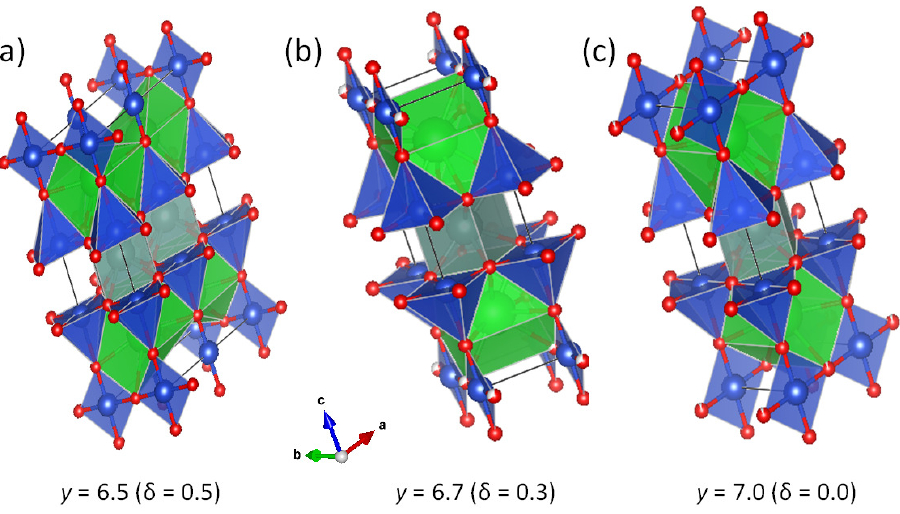
Figure 1. The crystal structures of ( RE )BCO as a function of the oxygen content. ( a ) y = 6.5 ( δ = 0.5), ( b ) y = 6.7 ( δ = 0.3), and ( c ) y = 7 ( δ = 0). Note that the doubled unit cell for δ = 0.5. The crystal structures were drawn using VESTA [25] and the cif-files from the ICDD database [27] and the Materials Project